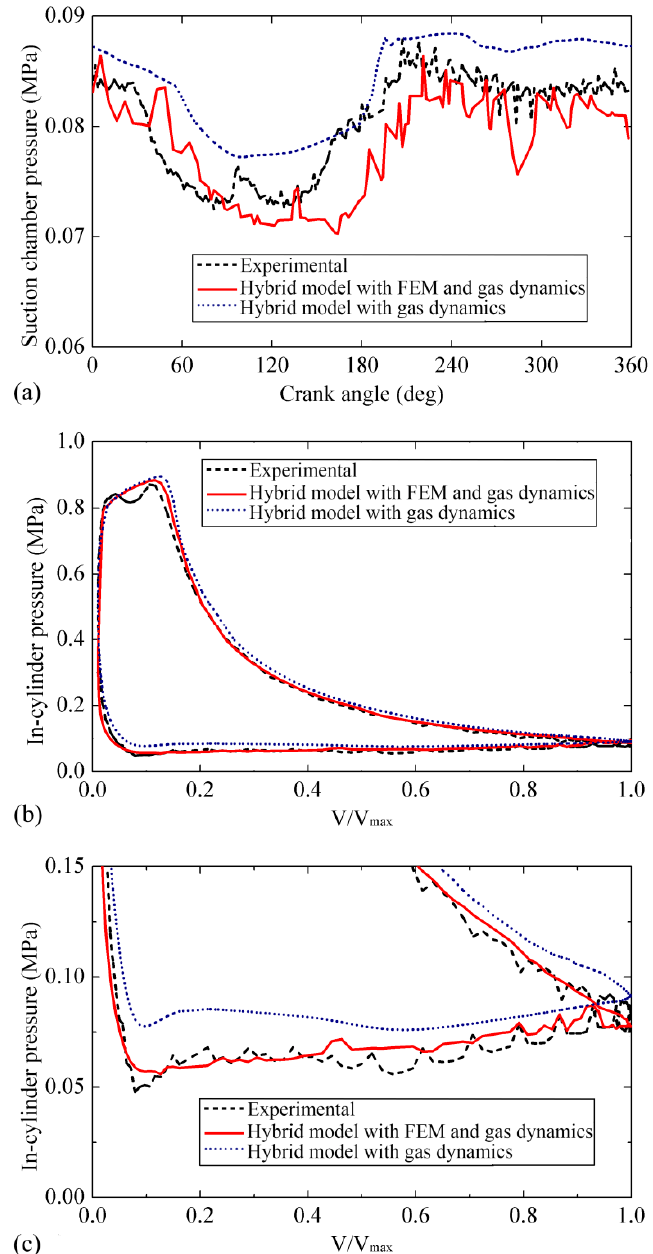
Figure 10. Comparsion of the predictions with experimental results: ( a ) suction pressure profiles; ( b ) in-cylinder pressure oscillations of a cycle and ( c ) suction phase detail.